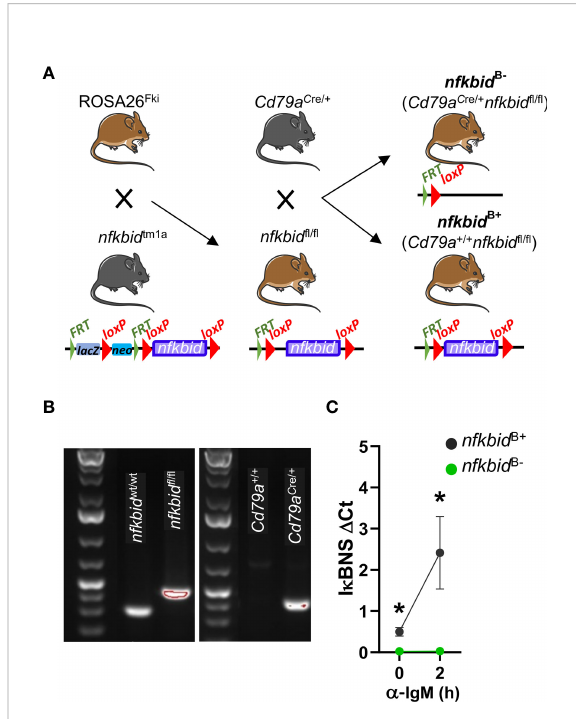
FIGURE 1 Generation and genotyping of B cell-speci fi c I k BNS knock-out mice. (A) Schematic overview of mouse strain crosses and targeted modi fi cation of the nfkbid locus. The Frt - fl anked lacZ and neo cassettes were removed from the nfkbid tm1a allele through Flp recombinase-mediated excision by